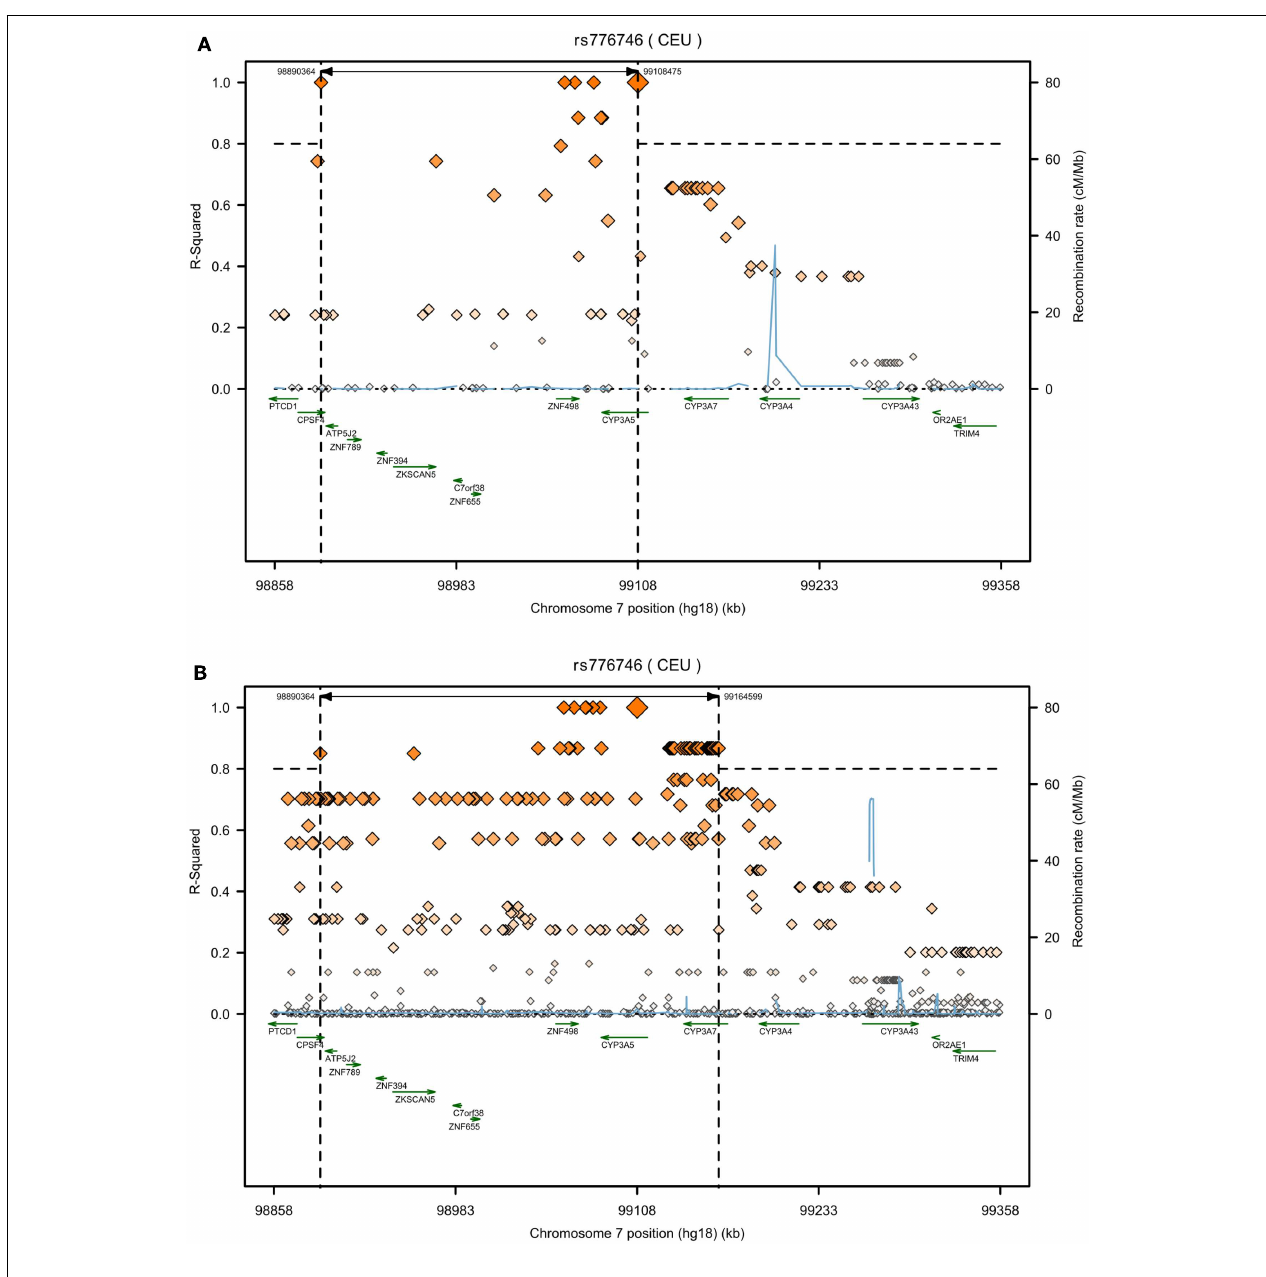
calculated versus the target SNP rs776746 (red squares) and recombination rates are given in cM/Mb (blue line); dashed lines mark the threshold for strong linkage R 2 = 0.8 (horizontal) and the corresponding region of linked SNPs (vertical); (A) HapMap3 Release 2, CEU (B) 1000 Genomes Pilot 1,